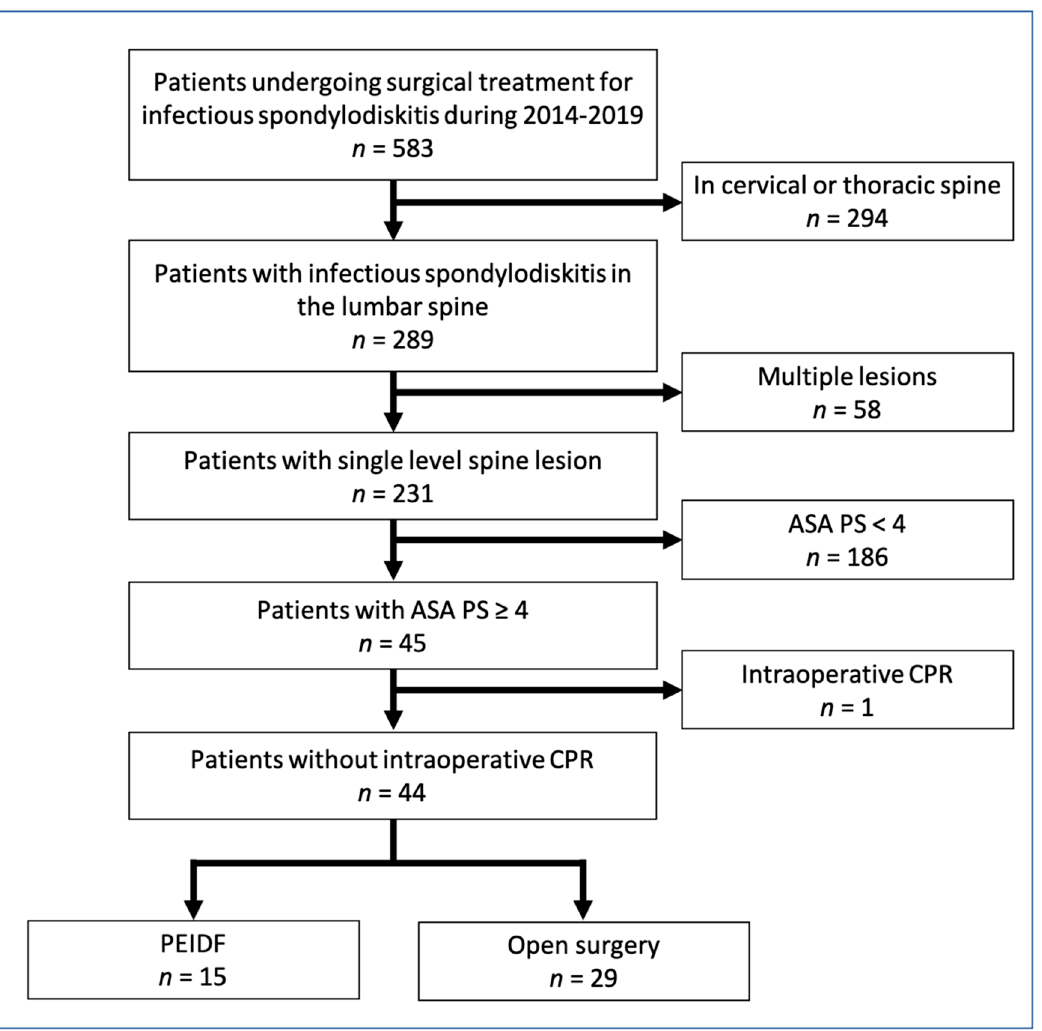
Figure 2. Flowchart of 2014–2019 cohort sample. ASA PS: American Society of Anesthesiologists physical status; CRP: C–reactive protein; PEIDF: percutaneous endoscopic interbody debridement and fusion.